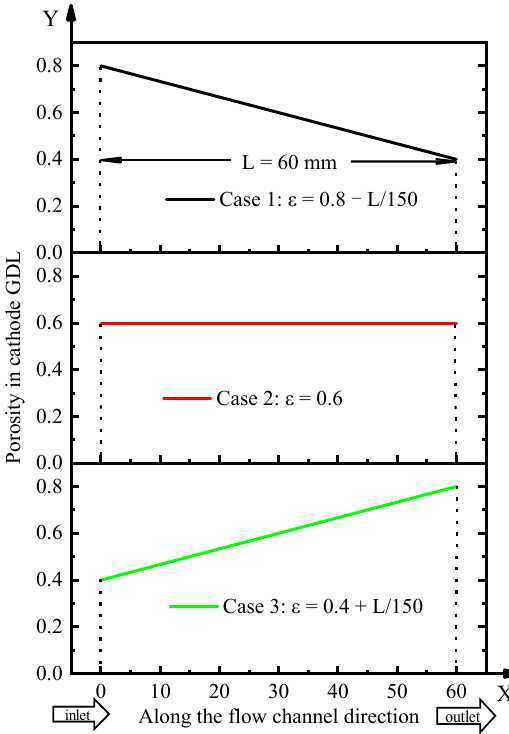
Figure 2. Porosity distribution of cathode GDL along the flow channel